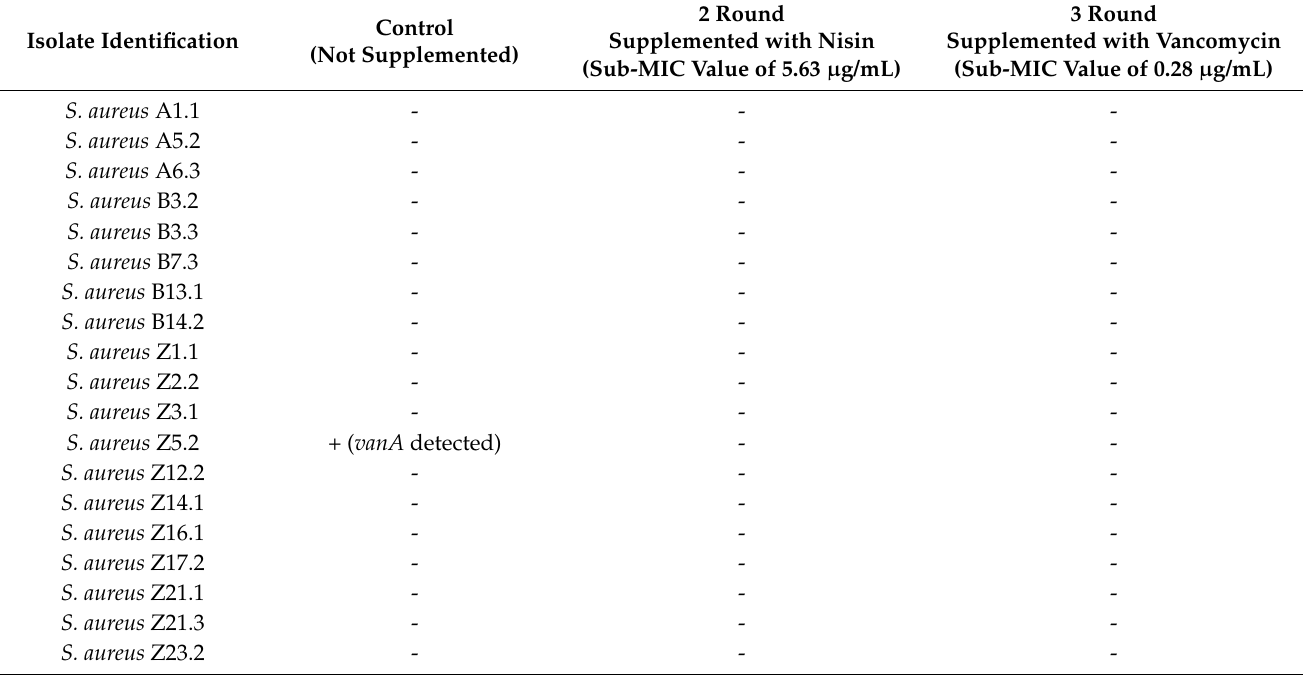
Table 2. Results obtained after the protocol of horizontal gene transfer in each matting round performed.